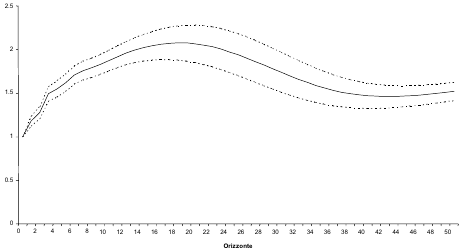
Figura 1f – Profilo di persistenza del settore Commercio (modello M3 ).